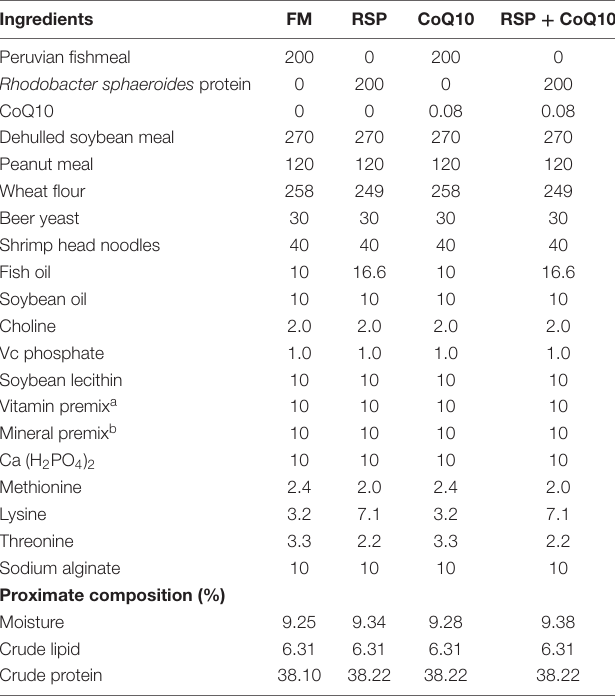
TABLE 1 | Ingredients and proximate composition of four experimental diets (g kg − 1